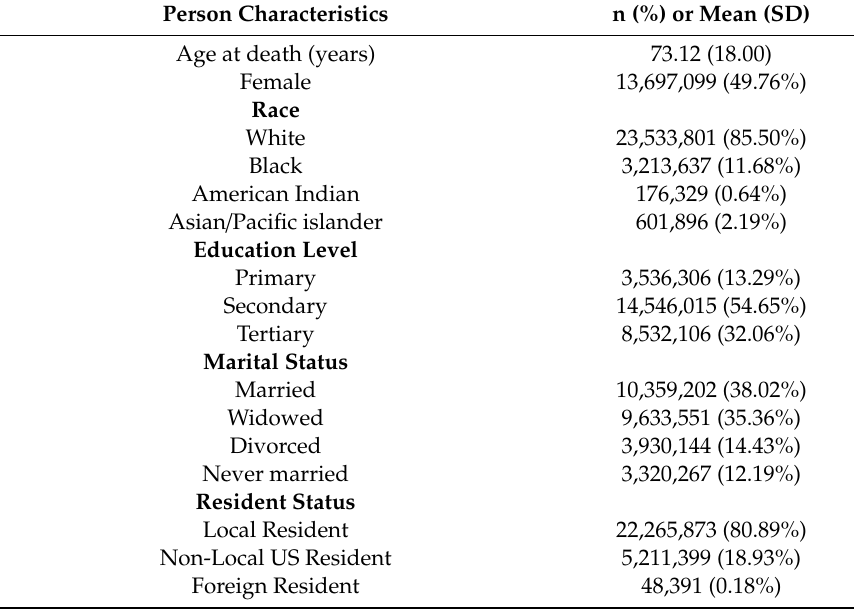
Table 1. Characteristics as reported in 27,525,663 death